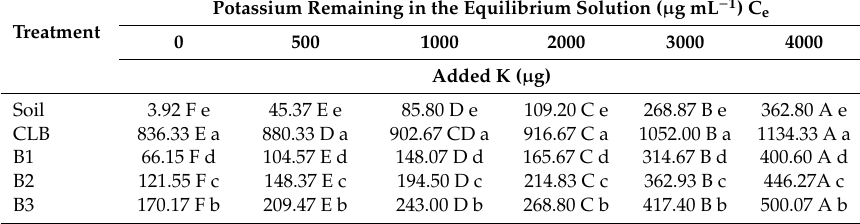
Table 6. Added potassium concentration on equilibrium solution potassium concentration in di ff erent treatments.